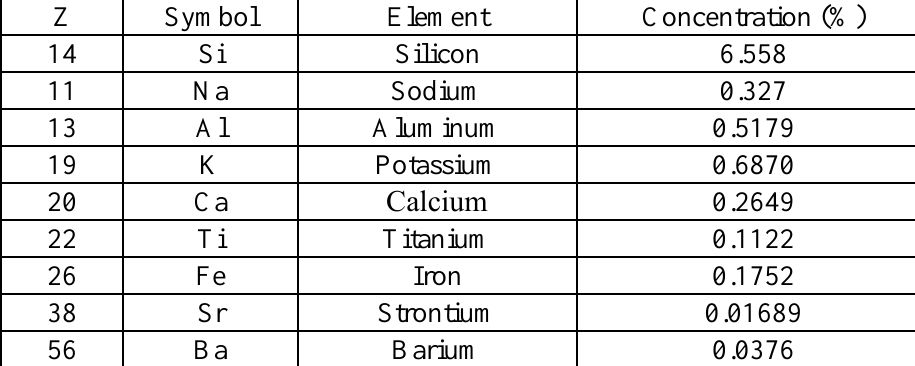
Table 2: Chemical analysis of